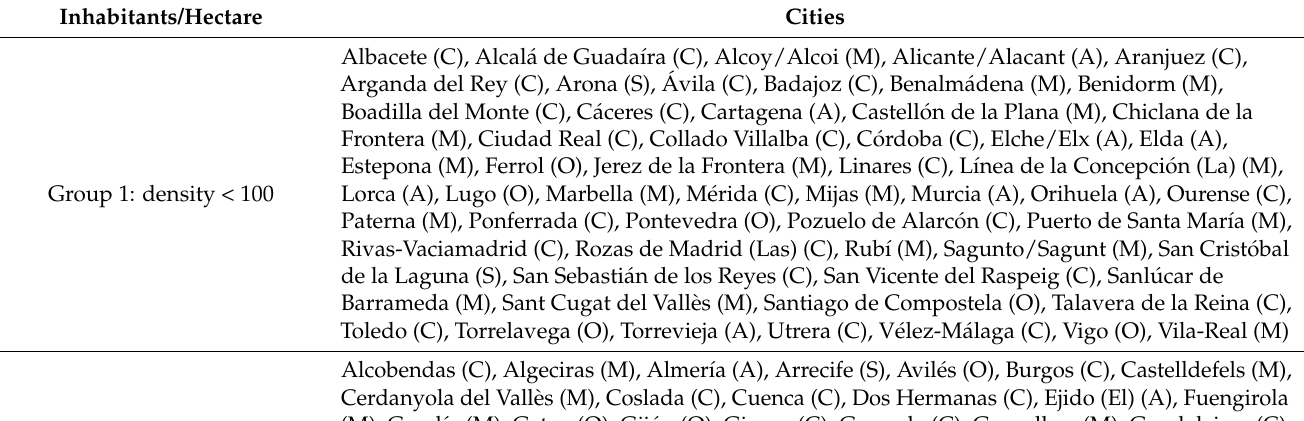
Table 1. Classification of Spanish cities by population density. Inhabitants/Hectare